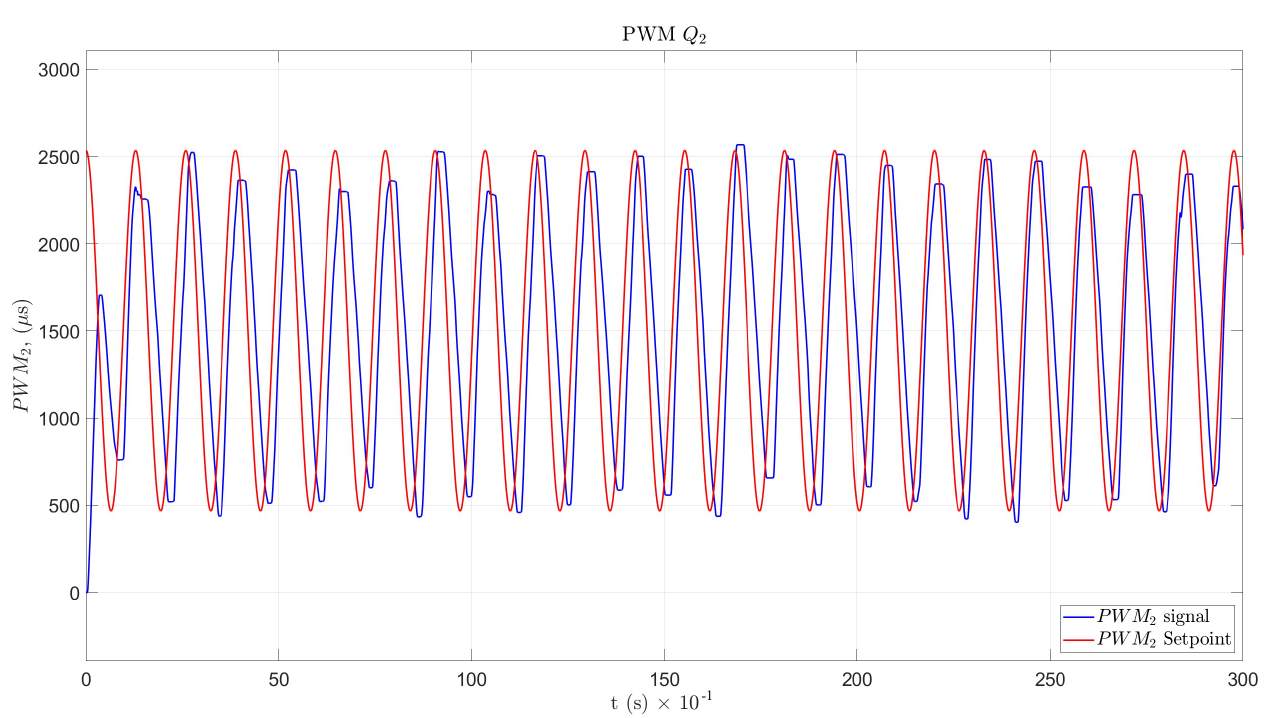
Figure 19. PWM velocity response for Q 1 .